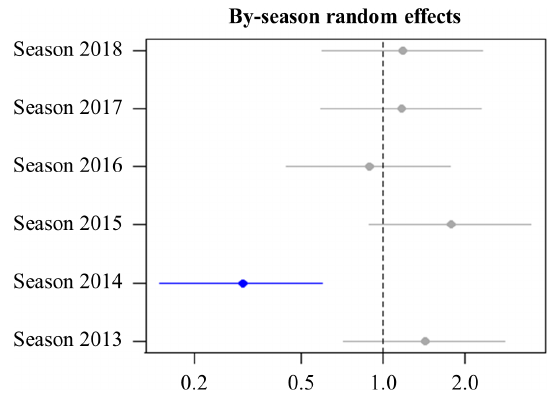
Figure 6. By-season random effects. The dots indicate the mean OR whereas the line represents the 95% credible interval. Blue and red dots indicate OR that are significantly smaller or larger than 1 (i.e., credible interval does not cross